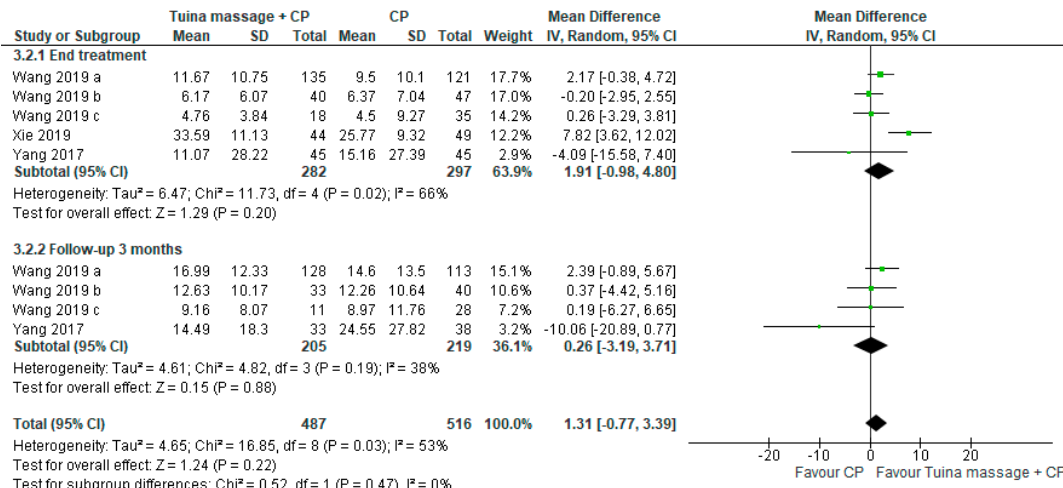
Figure 7. Forest plot of comparison of Tuina massage plus conventional physiotherapy (CP) versus CP for activities of daily living assessed by modified Barthel Index.